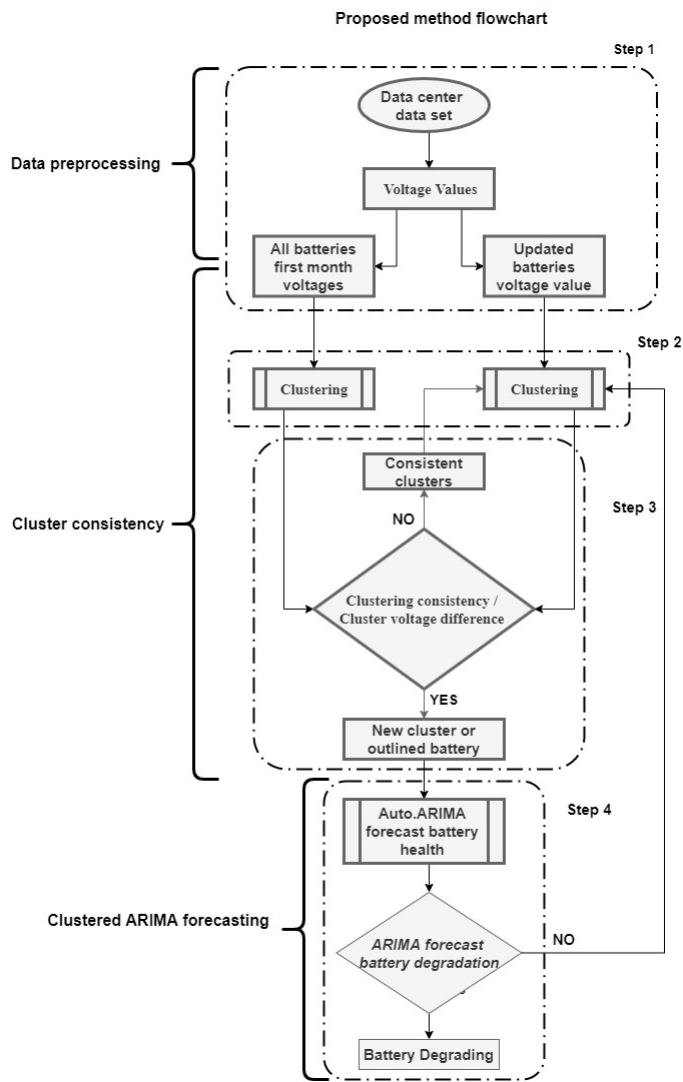
Figure 2. Proposed method